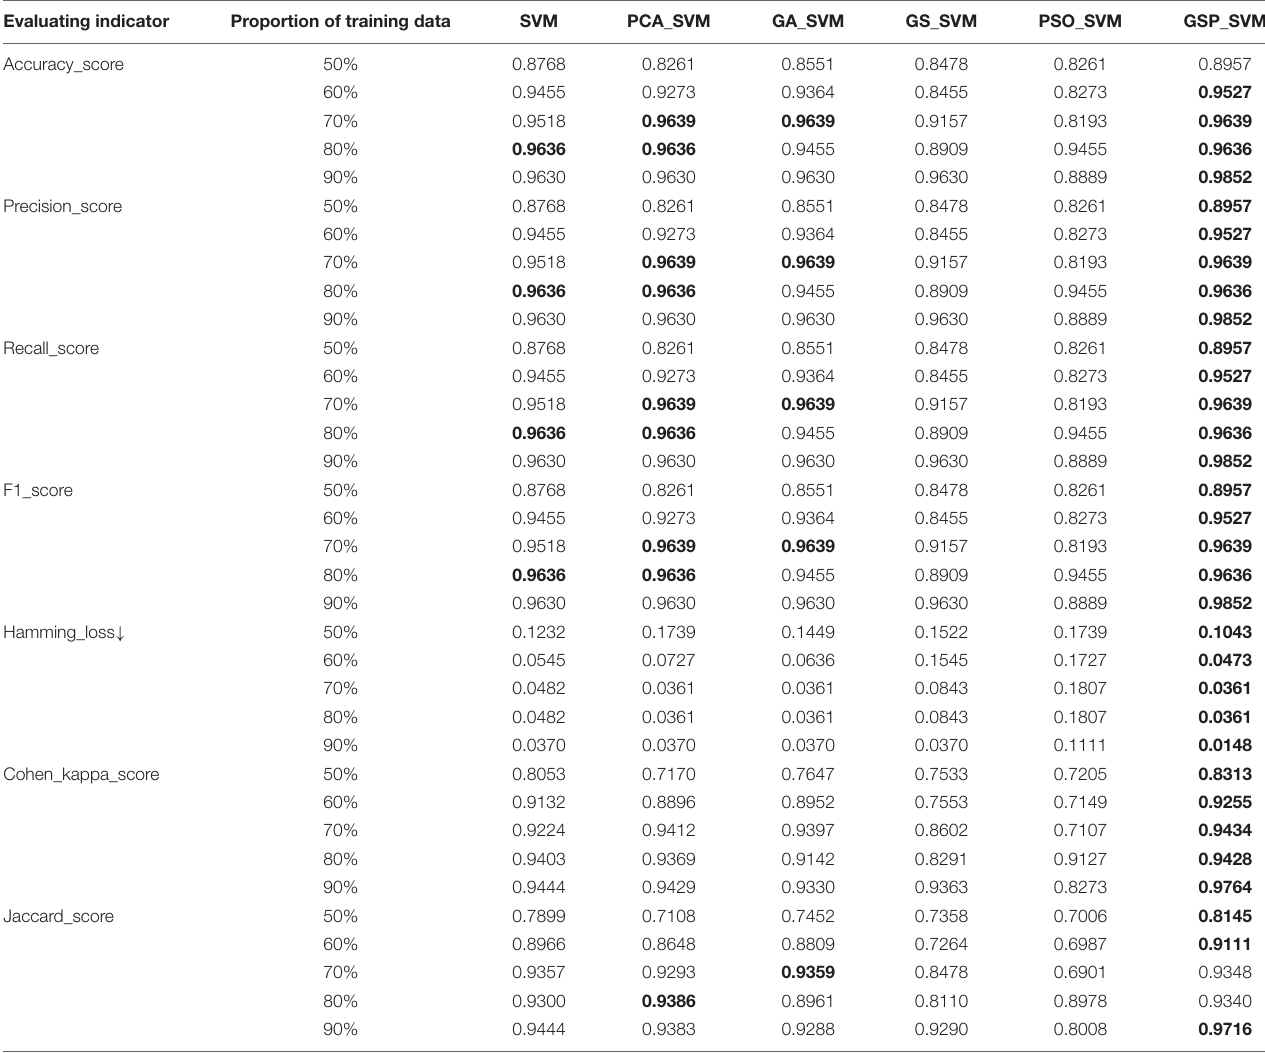
TABLE 4 | Evaluation results of multicategorical